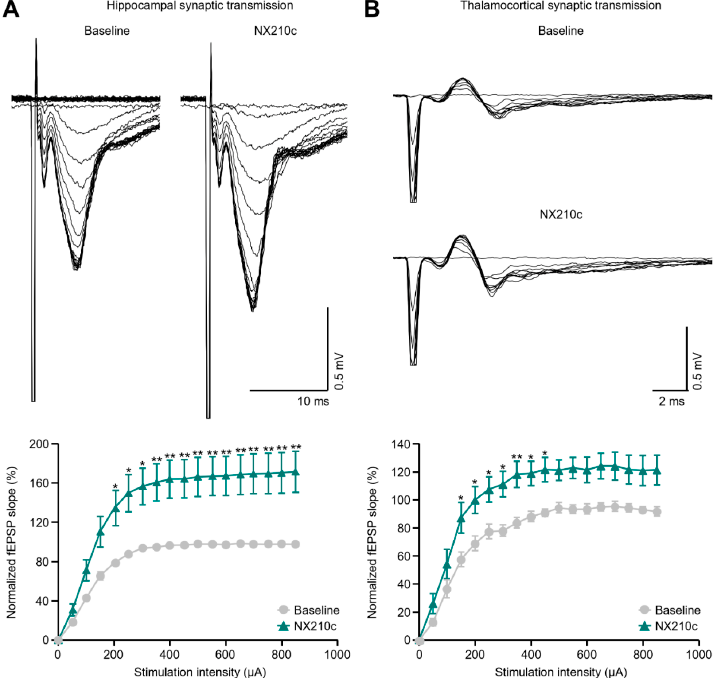
Figure 2. NX210c enhanced basal synaptic transmission in the brain. ( A , B ) Top panels: representative traces of extracellular field excitatory postsynaptic potentials (fEPSPs). ( A ) Measurements of extracellular fEPSP slopes normalized to the baseline in the hippocampal CA1 stratum radiatum after stimulation of Schaffer collaterals and commissural pathway in the absence and presence of NX210c at 250 µ g/mL. ( B ) Measurements of fEPSP slopes normalized to the baseline in the somatosensory cortex after stimulation of the ventroposteriomedial nucleus of the thalamus in the absence and presence of NX210c at 250 µ g/mL. ( A , B ) Repeated-measures two-way ANOVA followed by Šid á k’s multiple comparisons test: ** p < 0.01, * p < 0.05 compared with baseline; n = 10 slices from 5 mice (i.e., 2 slices per